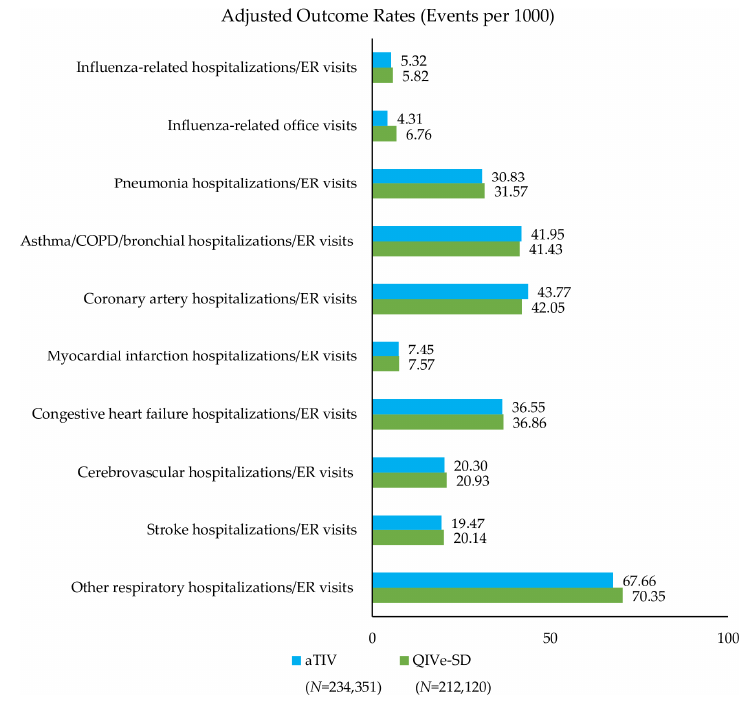
Figure 3. Adjusted outcome rates — post-IPTW — aTIV vs. quadrivalent influenza vaccine (QIVe-SD). Rate = events per 1000 vaccinated-subject seasons.